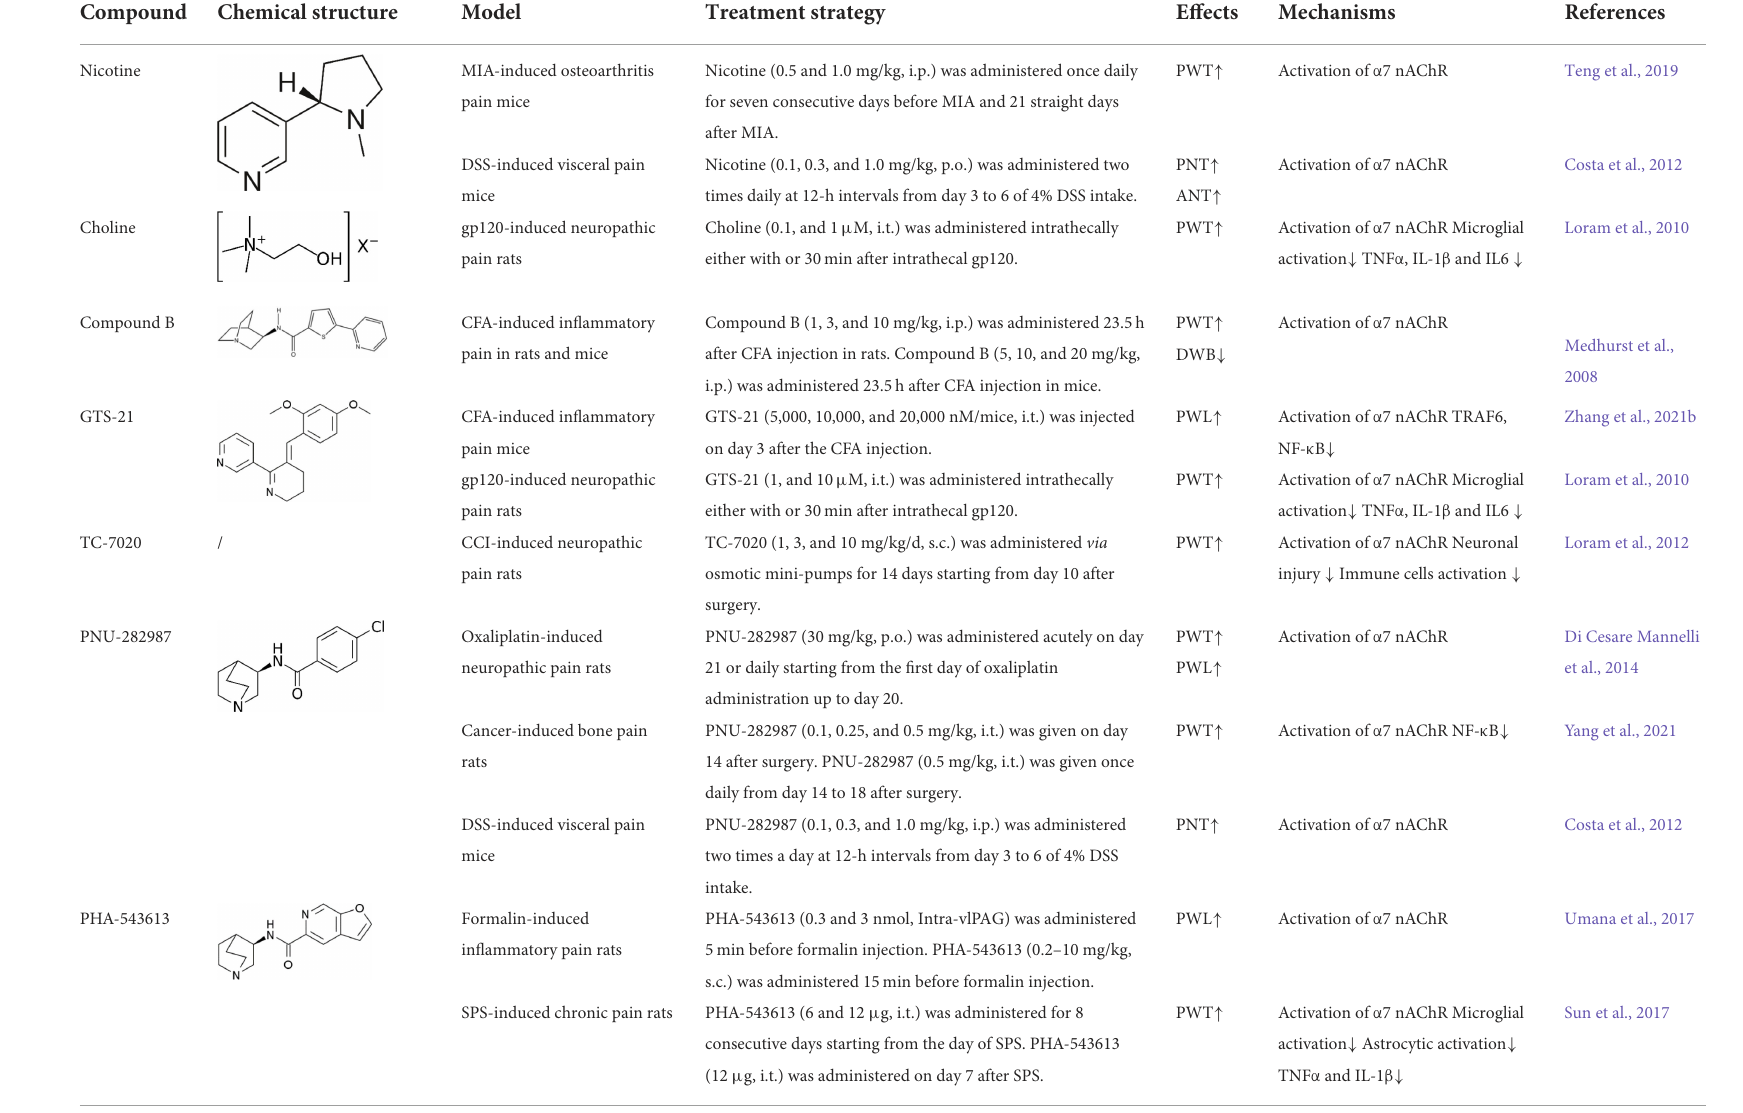
TABLE 1 Summary of the therapeutic potential of α 7 nAChR agonists and allosteric modulators in chronic